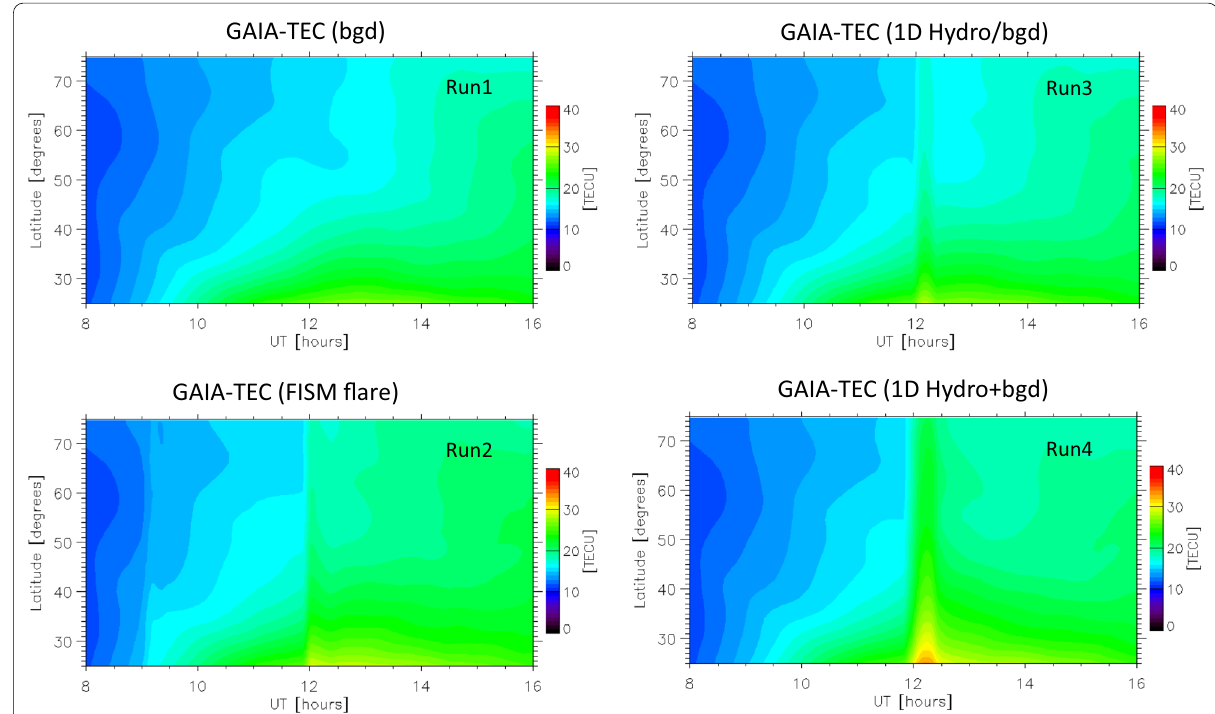
Fig. 7 TEC distribution at 0°E 25–75°N calculated by GAIA. TEC distribution derived by inputting (upper left: Run1) background, (lower left: Run2) “FISM”, (upper right: Run3) “1D Hydro/bgd”, and (lower right: Run4) “1D Hydro